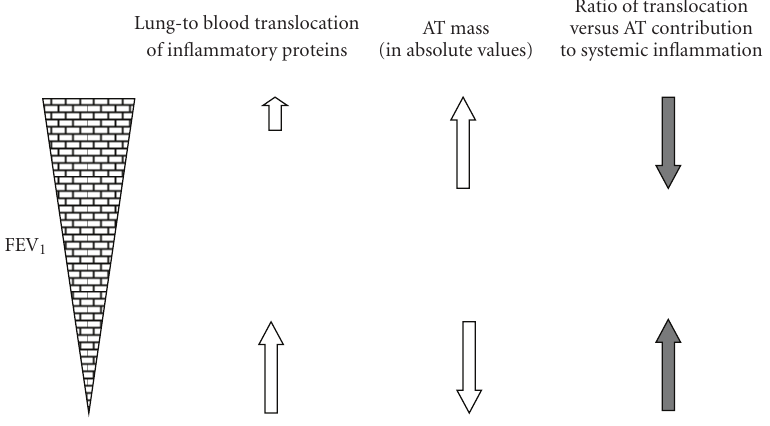
Figure 1: Concept of di ff erential contribution of lung-to-blood translocation of inflammatory proteins versus adipose tissue inflammation to the overall systemic inflammatory phenotype in COPD. We suggest that in patients with mild COPD and concurrent obesity, adipose tissue (AT) is the key contributor to systemic inflammation, whereas in those with severe COPD, lung-to-blood translocation of inflammatory proteins plays the major